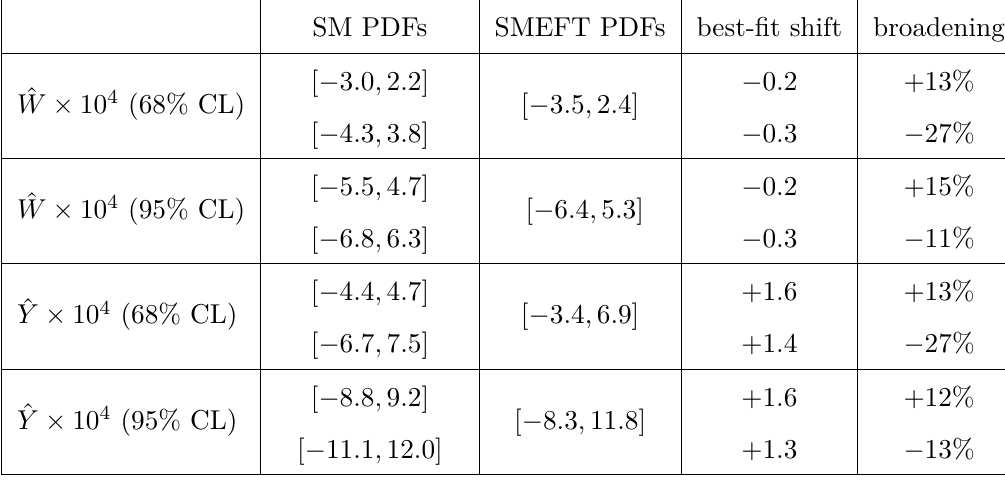
Table 4 . The 68% CL and 95% CL bounds on the ˆ W and ˆ Y parameters obtained from the corresponding parabolic fits to the ∆ χ 2 values calculated from either the SM or the SMEFT PDFs. For the SM PDF results, we indicate the bounds obtained without (upper) and with (lower entry) PDF uncertainties accounted for; the SMEFT PDF bounds already include PDF uncertainties by construction, while the methodological (finite-size) uncertainty is included according to the approached described in section 3.4. The fourth and fifth column indicate the absolute shift in best- fit values, eq. (4.3) and the percentage broadening of the EFT parameter uncertainties, eq. (4.4), when the SMEFT PDFs are consistently used instead of the SM